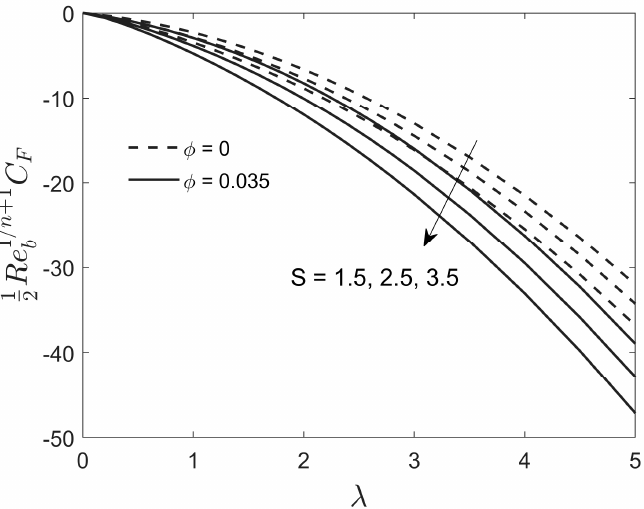
Figure 18. Effect of suction on the skin friction coefficient against stretching/shrinking.